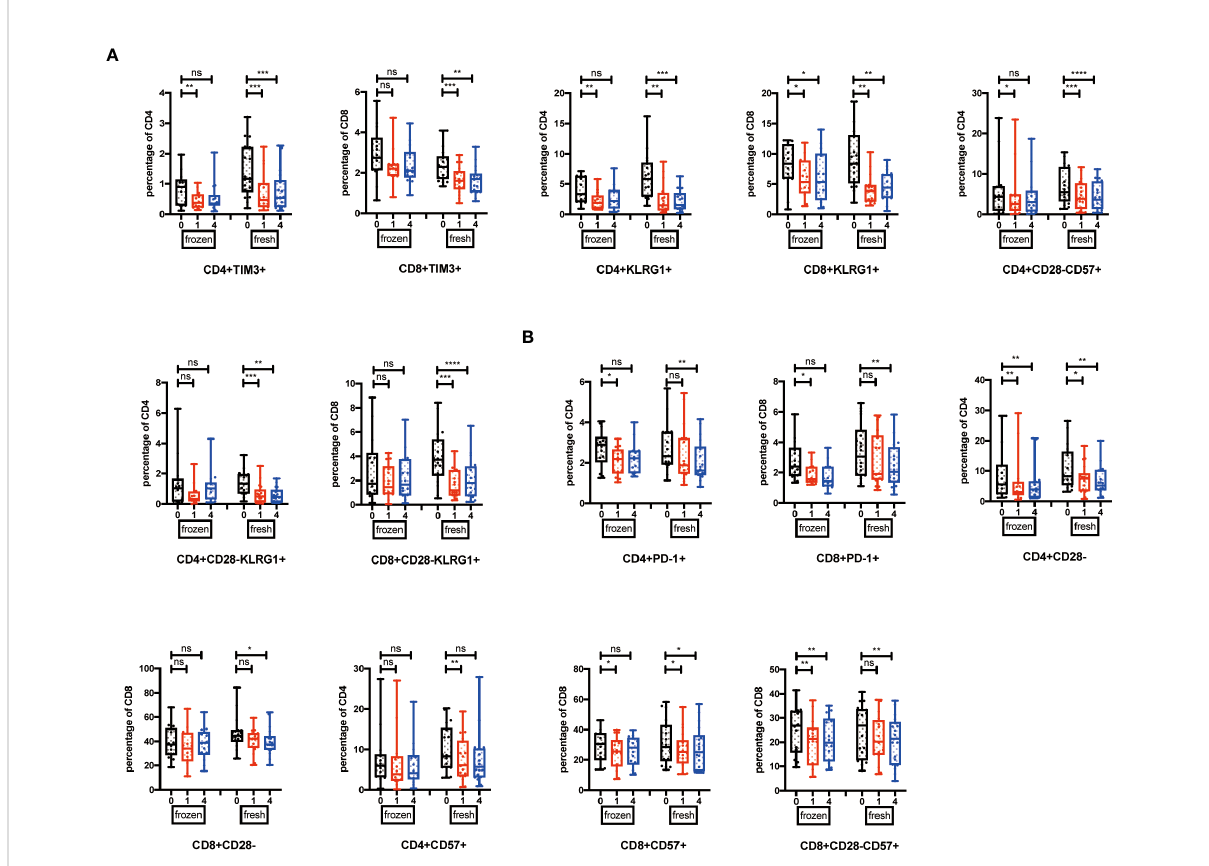
FIGURE 4 Cell types in fl uence the effects induced by NK cell infusion. (A) Percentages of TIM-3 + , KLRG1+, CD28 - CD57 + , and CD28 - KLRG1 + T cells were analyzed in both fresh and frozen groups by fl ow cytometry on the 1 week and 4 weeks after NK cell infusion. (B) Percentages of PD-1 + , CD28 - , and CD57 + T cells were analyzed in both fresh and frozen groups by fl ow cytometry on the 1 week and 4 weeks after NK cell infusion. Each marker has detected 32 volunteers; 14 volunteers are involved in the frozen group, and 18 volunteers are involved in the fresh group. * p < 0.05; ** p < 0.01; *** p < 0.001; **** p < 0.0001. ns, no